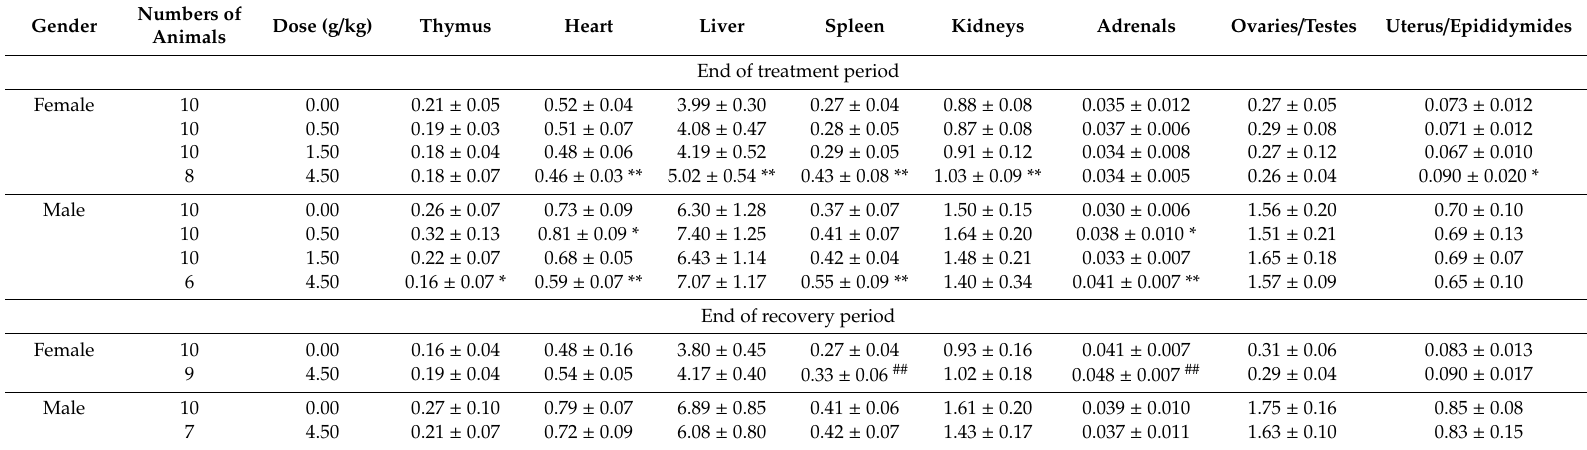
Table 3. Relative organ weights to brain (%) of S-D rats orally administrated with gardenia yellow for 90 days.